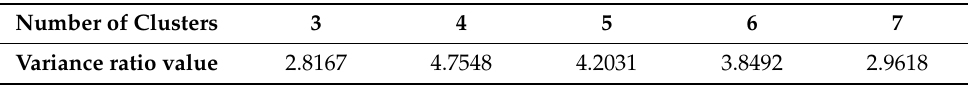
Table 1. The number of clusters analyzed by variance ratio criterion.